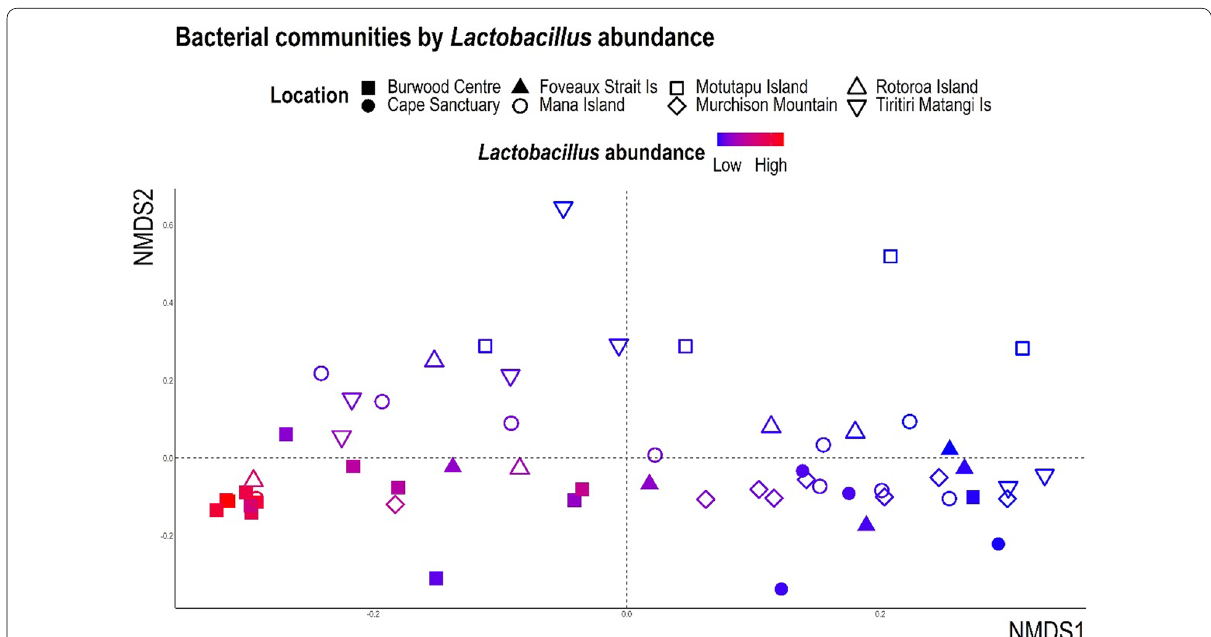
Fig. 2 Bray–Curtis dissimilarity distances visualised via NMDS ordination. Bacterial communities are coloured according to relative Lactobacillus 16S rRNA gene sequence abundance and shaped according to location. Each dot of the NMDS represents a single takahē faecal sample (MDS stress =